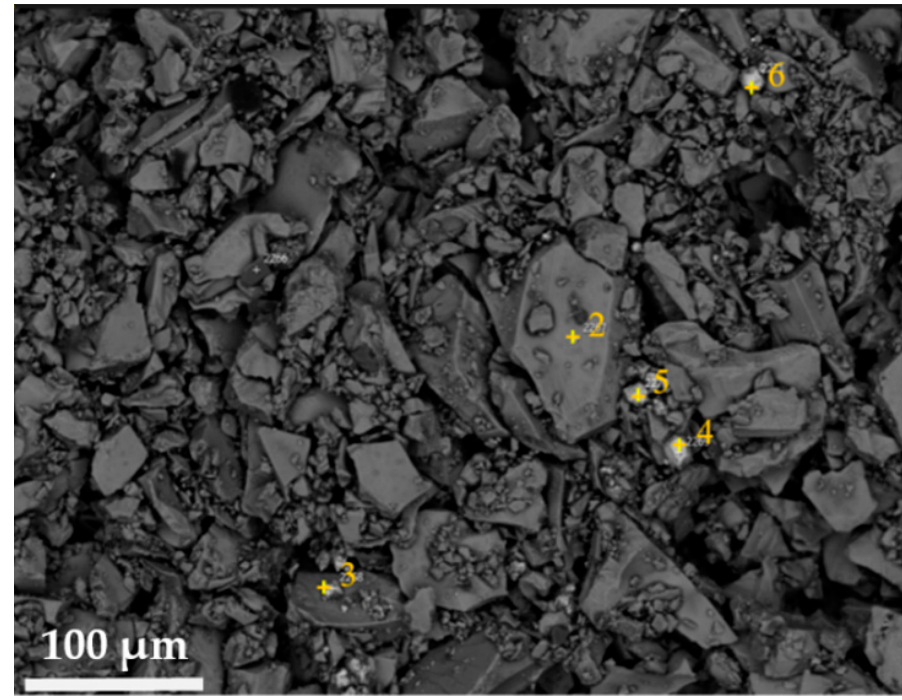
Figure 9. The micrograph of magnetic agglomerate. Table 3. The results of microprobe analysis. No. of Grade of Elements (wt. Spectrum